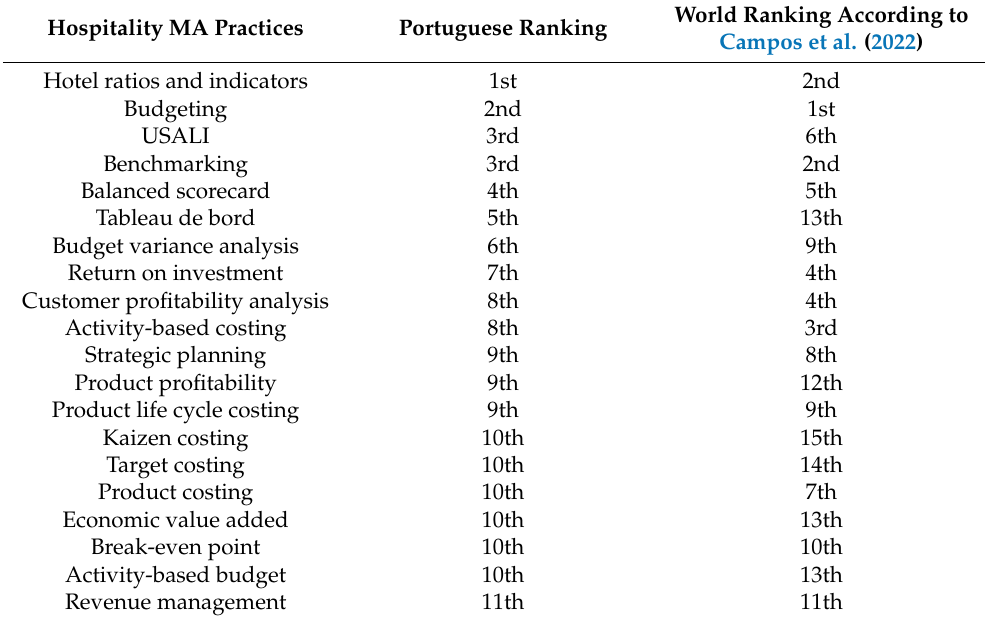
Table 3. Portuguese ranking vs. world ranking on hospitality MA